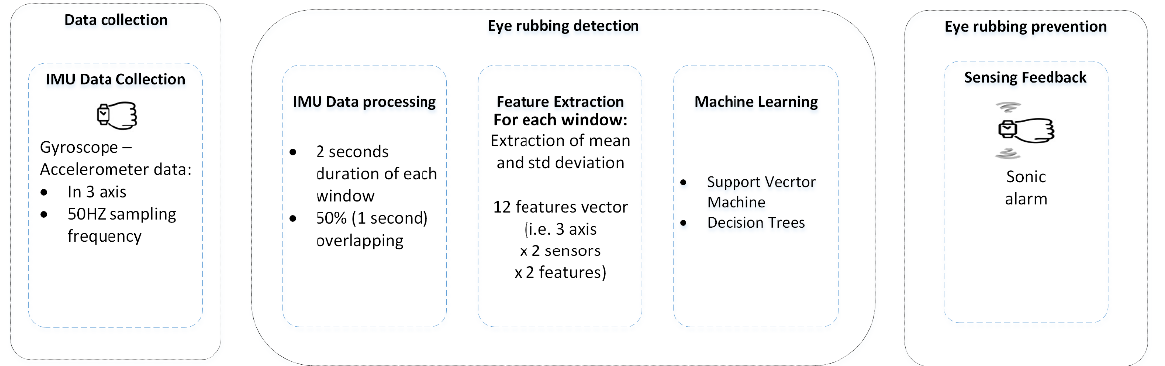
Figure 1. High-level architecture and case scenario of the proposed system .